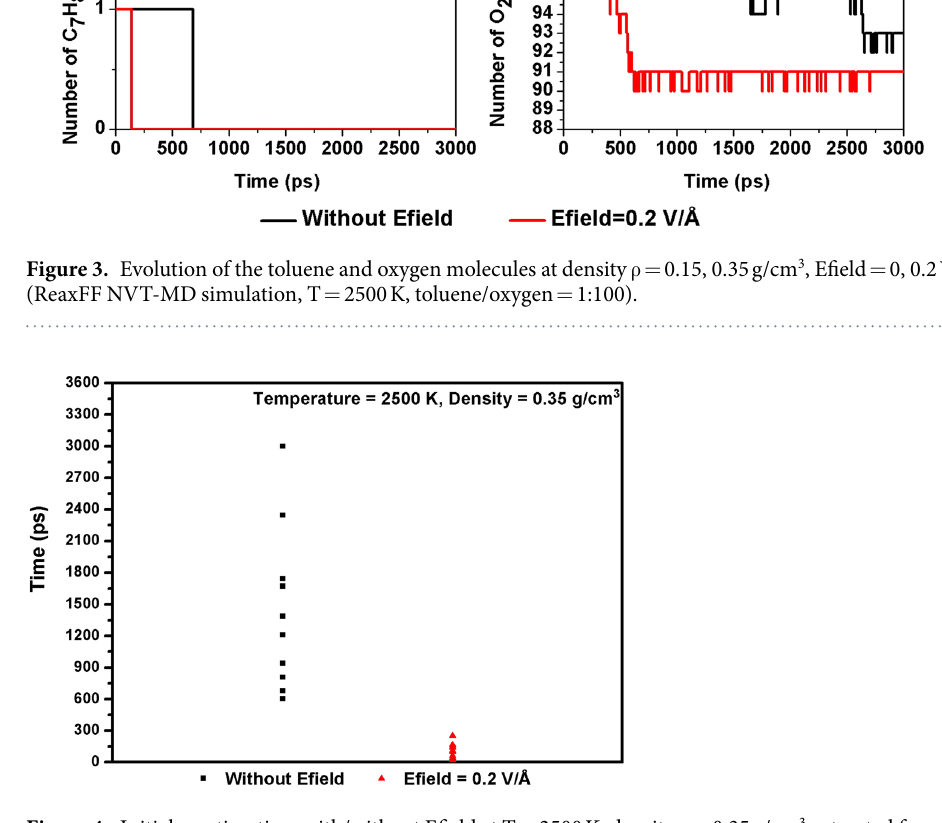
Figure 4. Initial reaction time with/without Efield at T = 2500 K, density ρ = 0.35 g/cm 3 extracted from ReaxFF NVT-MD